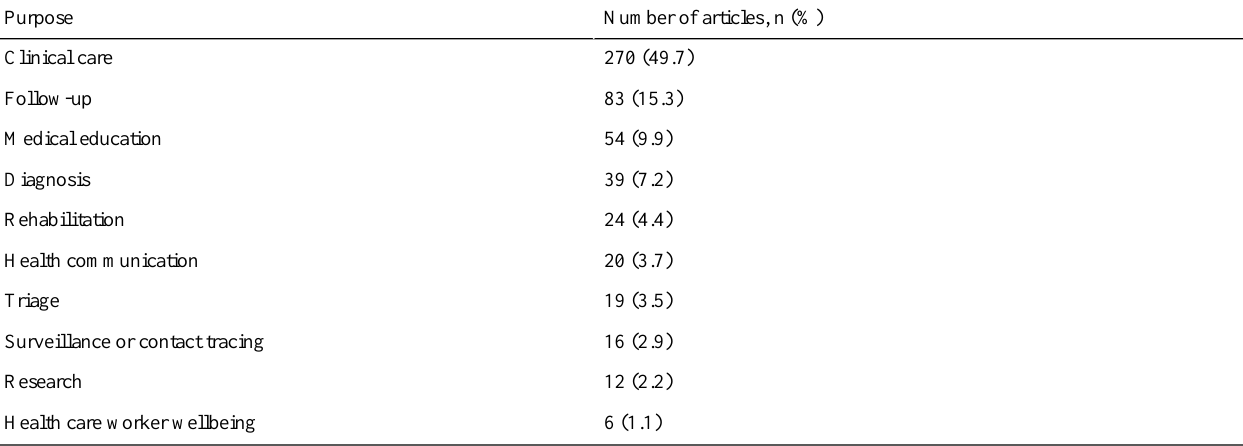
Table 3. Various purposes of telehealth use during the COVID-19 pandemic